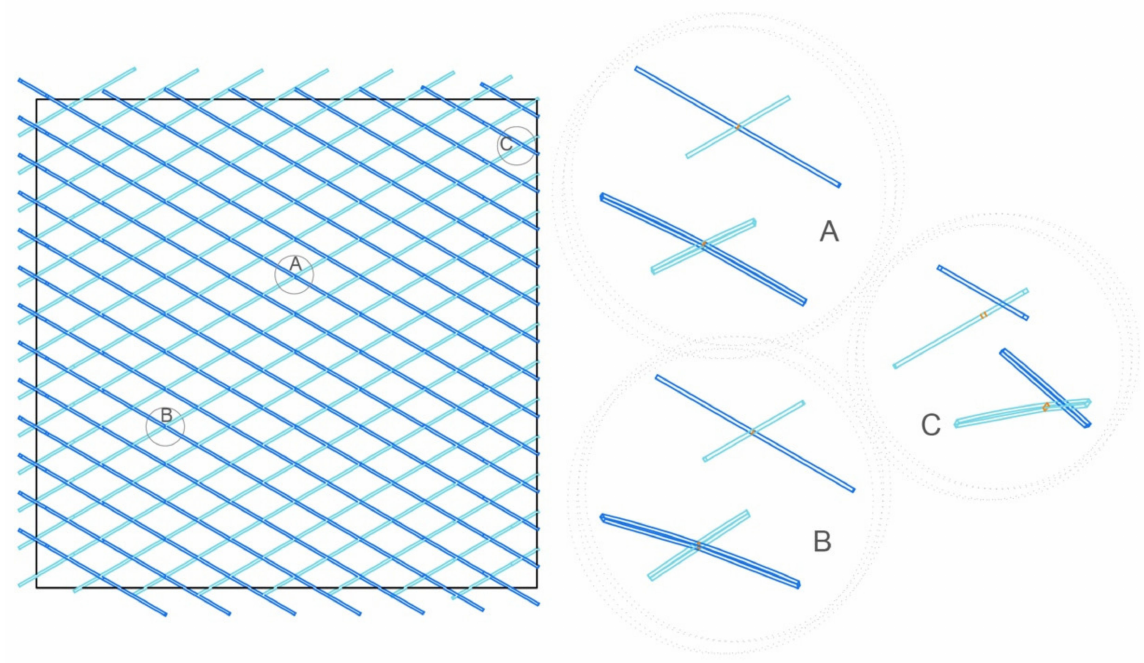
Figure 5. The plan and details of the lamella vault for the graphical method of connecting the lamellae in an arch with details A, B and C showing the misplacement of the connecting lamellae in the